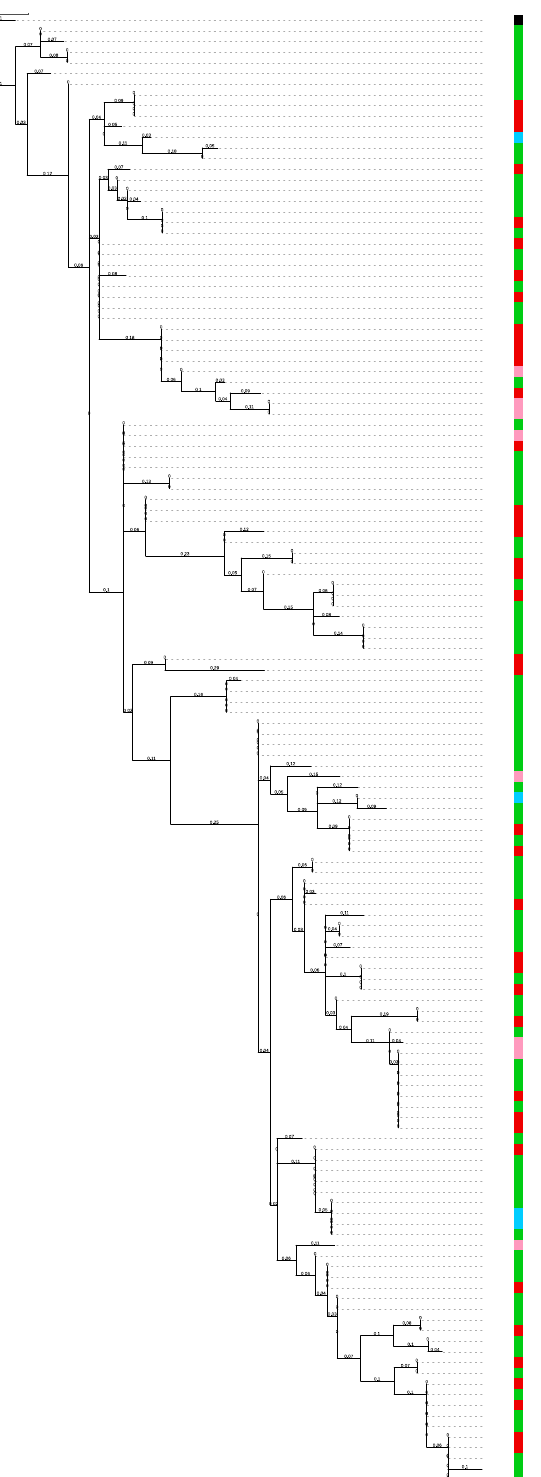
Figure 1. Phylogenetic tree based on the amino acid sequence of the csd alleles HVR region in 7 different Italian honeybee subspecies. Colors are given according to evolutionary lineages: A. m. sicula belongs to the African type (pink); A. m. mellifera belongs to the western and northern Europe lineage (blue); A. m. carnica, A. m. cecropia and A. m. ligustica belong to the eastern Europe group (green); Buckfast and hybrid Carnica are crosses of European subspecies belonging to C type (red). The tree was rooted on Apis cerana